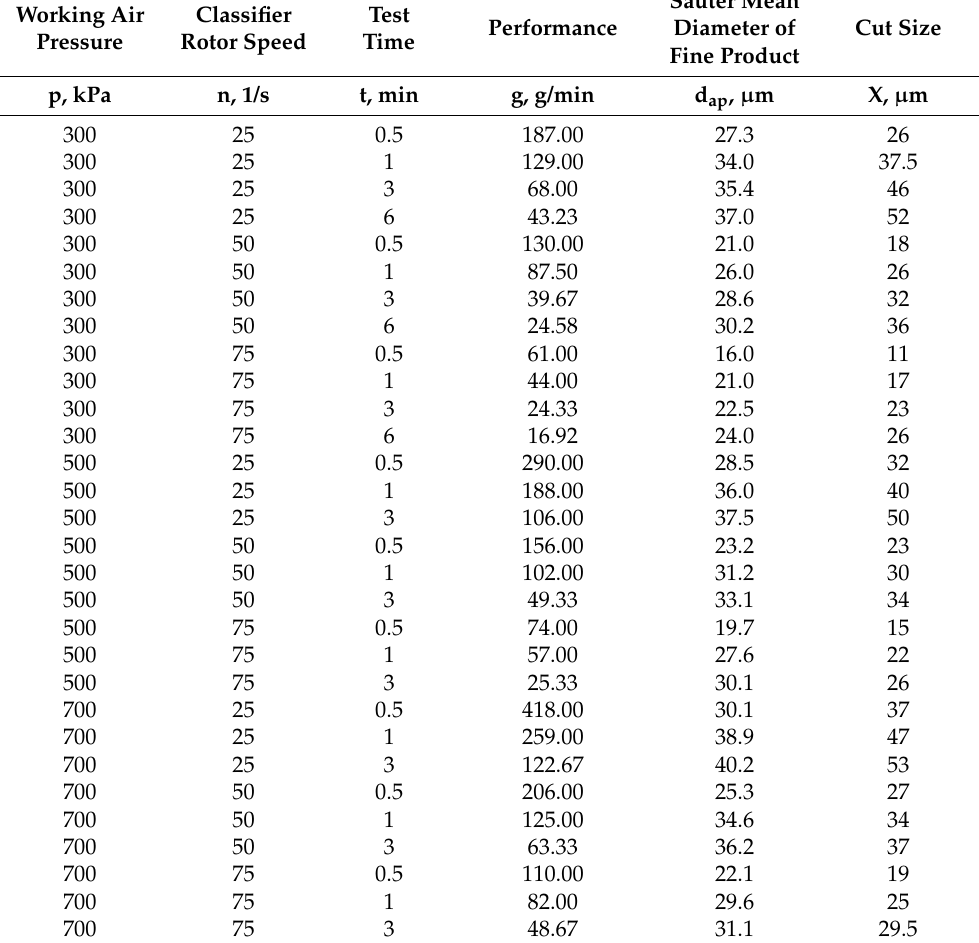
Table 1. Performance values, Sauter mean diameter of fine product and cut size for different test times, for different rotational speeds of classifier rotor, and for different pressures of working air (first series).